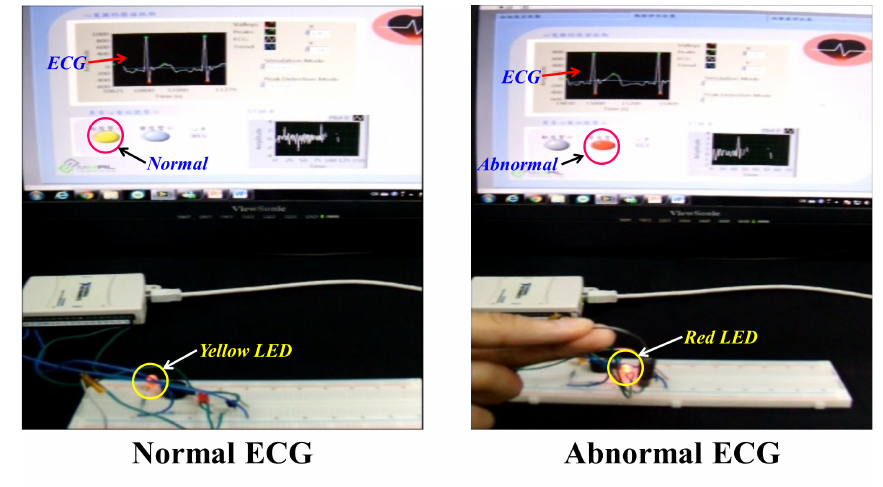
Figure 17. Accuracy assessment result of